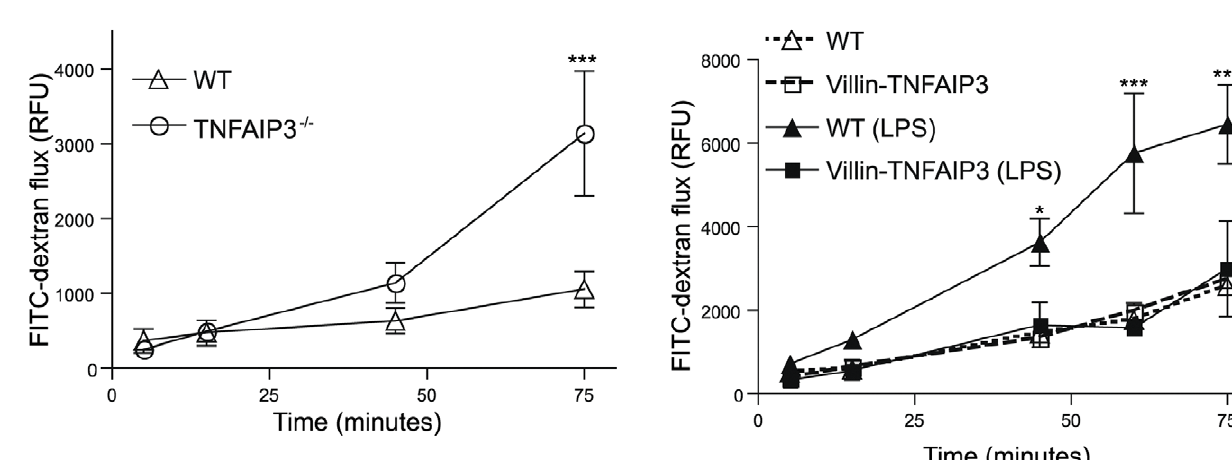
Figure 2. TNFAIP3 is required to maintain intestinal barrier function. Explanted intestinal loops from untreated wild type (WT; triangles) and TNFAIP3 deficient mice (TNFAIP3 2 / 2 ; circles) were examined for loss of barrier function. The flux of FITC-dextran over time out of the loops was measured in relative fluorescent units (RFU) per cm of intestinal tissue. Increased FITC-dextran flux indicates decreased barrier function. (***p , 0.001).